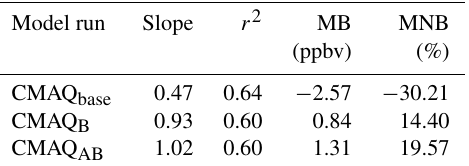
Figure 6. (a) The hourly output of CMAQ base NH x is shown in the background with the measured (1min average) NH x concentrations within the modeled hour shown as the dots for the daytime flight on 16 June 2010 and (b) a nighttime flight on 24 May 2010, and (c) the same nighttime flight but for the CMAQ AB scenario. Table 3. Summary statistics of the CMAQ RVMR to TES RVMR NH 3 comparisons for four CalNex overpasses (05 / 28, 05 / 30, 06 / 13, 06 / 15). Mean bias (MB) = mean (modeled–measured); mean nor- malized bias (MNB) = mean